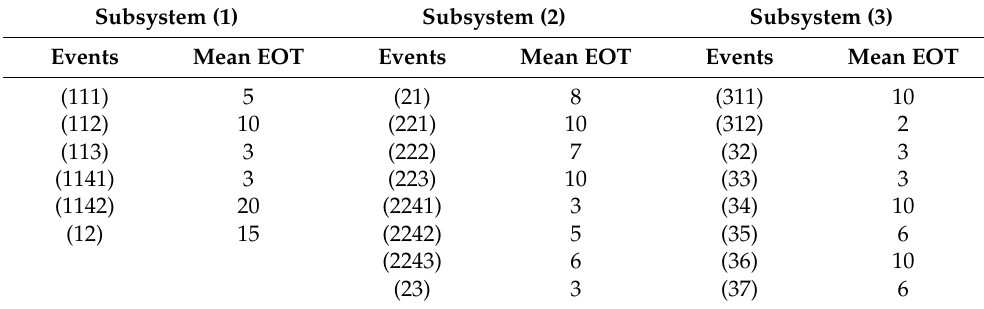
Table 1. Initial